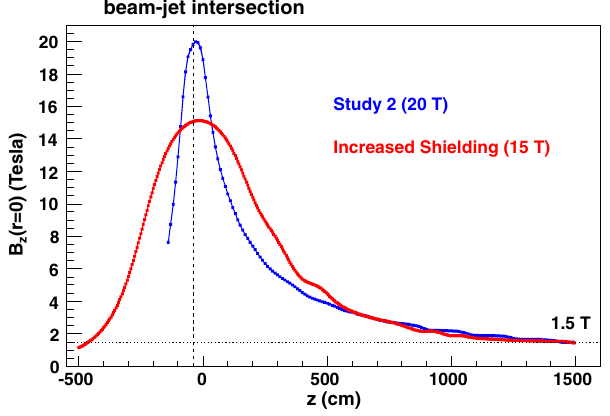
FIG. 5. Axial magnetic field profile distributions for the Study 2 and new increased shielding